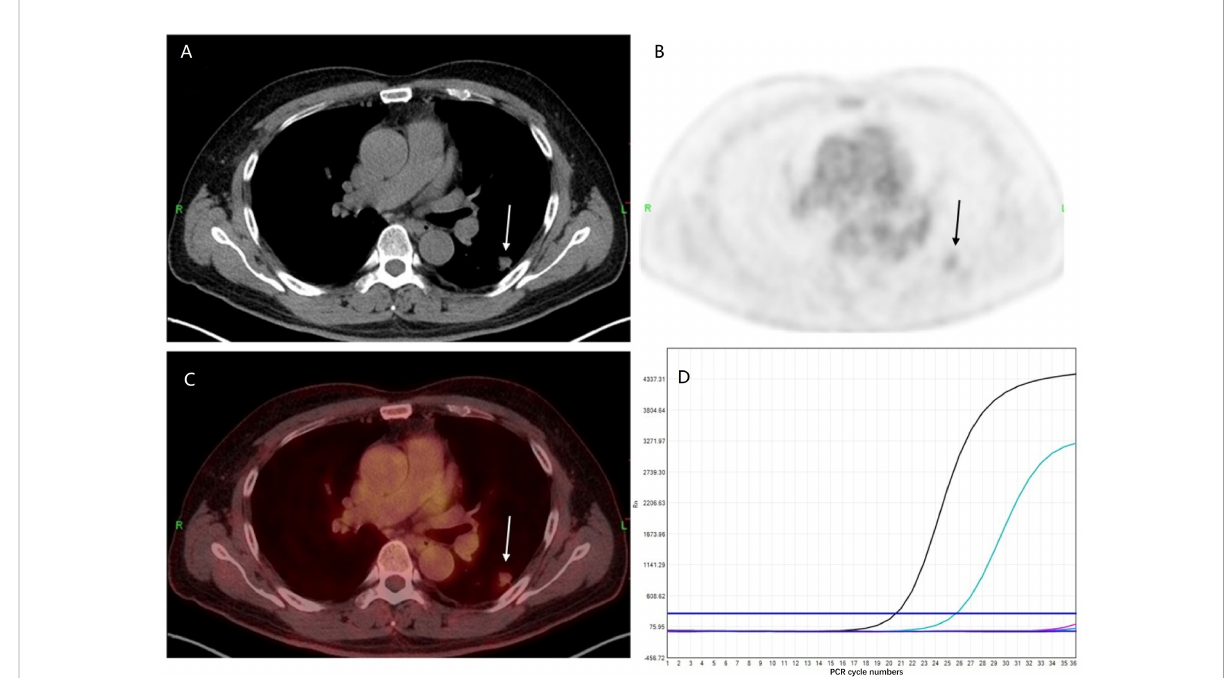
FIGURE 1 Representative epidermal growth factor receptor (EGFR) status and 18 F-FDG PET/CT fi nding. A 53-year-old man with EGFR wild-type lung adenocarcinoma. (A) CT, (B) PET, and (C) PET/CT fusion images show a 1.0-cm-sized mild 18 F-FDG uptake mass in the dorsal segment of the left lower lobe (SUVmax = 2.3) (arrow). (D) Genetic testing demonstrates wild-type EGFR